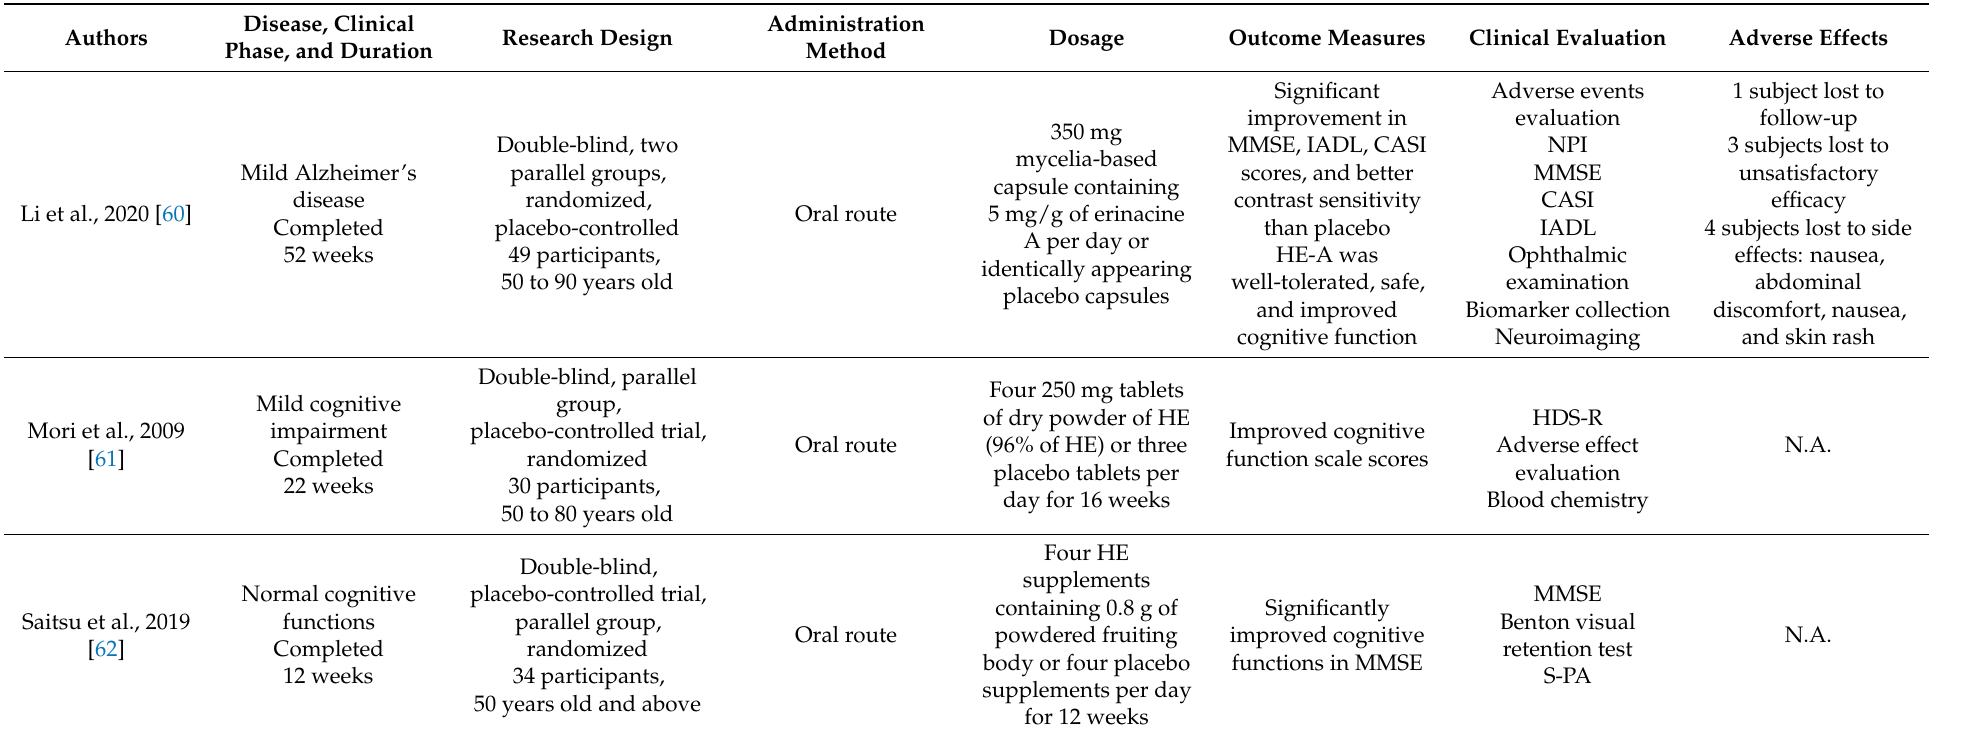
Table 2. Clinical studies of Hericium erinaceus in AD